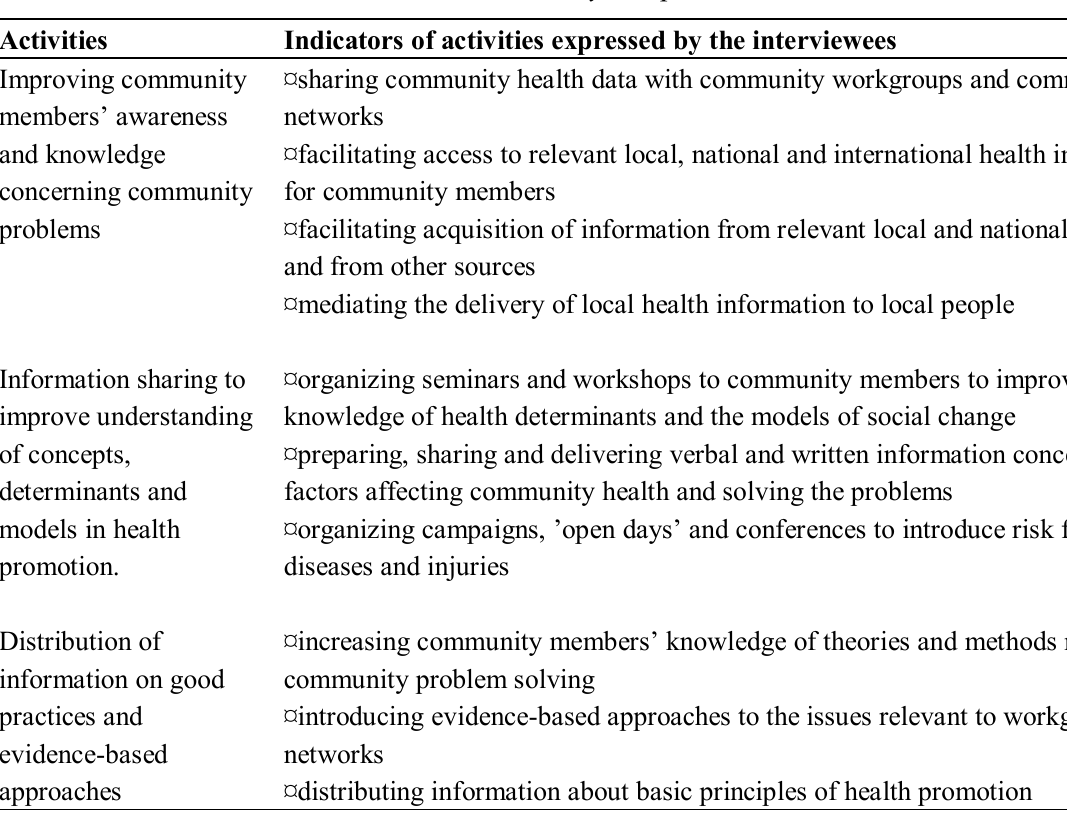
Table 5. Activities and indicators of activities expresses as empowering by the interviewees within the domain of Community competence